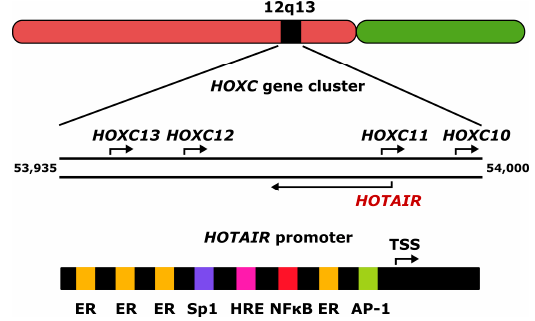
Figure 1. The 2158 nucleotide long human HOX transcript antisense RNA (HOTAIR) gene is located within the 12q13 chromosomal region in the HOXC (homeobox C) gene cluster and is transcribed from the antisense strand of the cluster. The promoter of the HOTAIR gene contains binding sites for many transcription factors, including several estrogen response elements (ER) and sites for specificity protein 1 (SP1), nuclear factor kappa B (NF- κ B), activator protein 1 (AP1), hypoxia response elements (HRE). TSS–transcription start site; the upper strand of the HOXC cluster is presented in the 5 (cid:48) → 3 (cid:48) orientation as is the HOTAIR promoter; the numbers indicate chromosomal position of the HOXC cluster in bp; arrows show the direction of transcription.